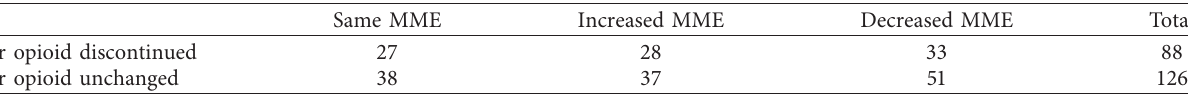
Table 4: Frequency of opioids prescribed prior to ED